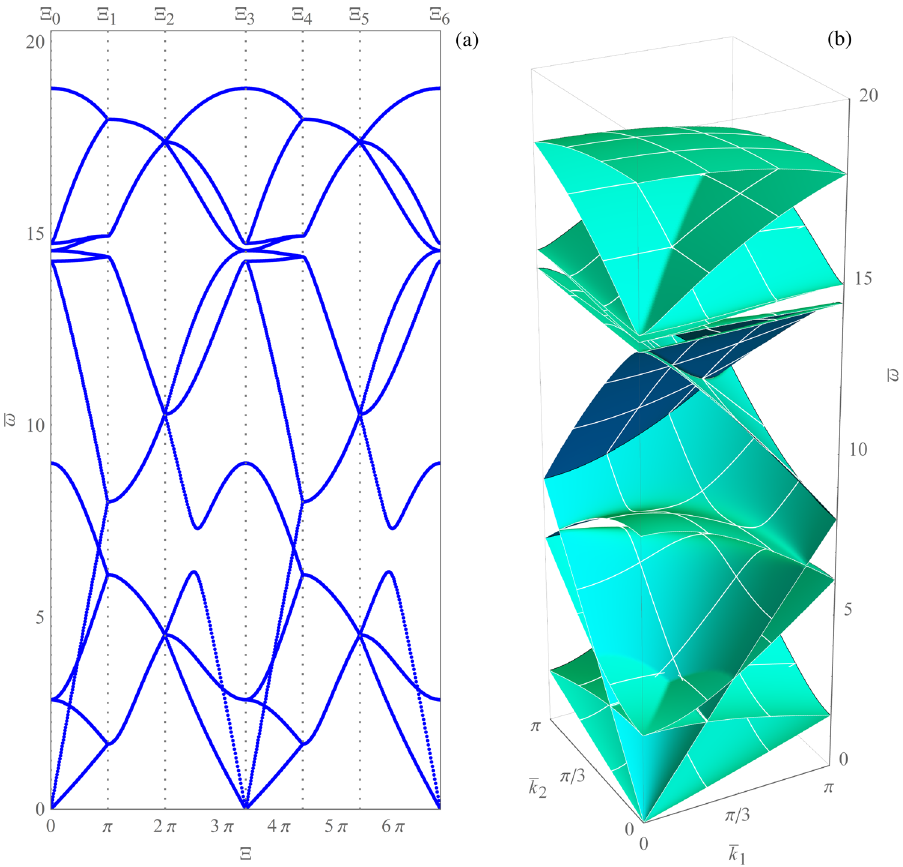
Figure 3. Anti-tetrachiral metamaterial C 0 : ( a ) frequency spectrum; ( b ) dispersion